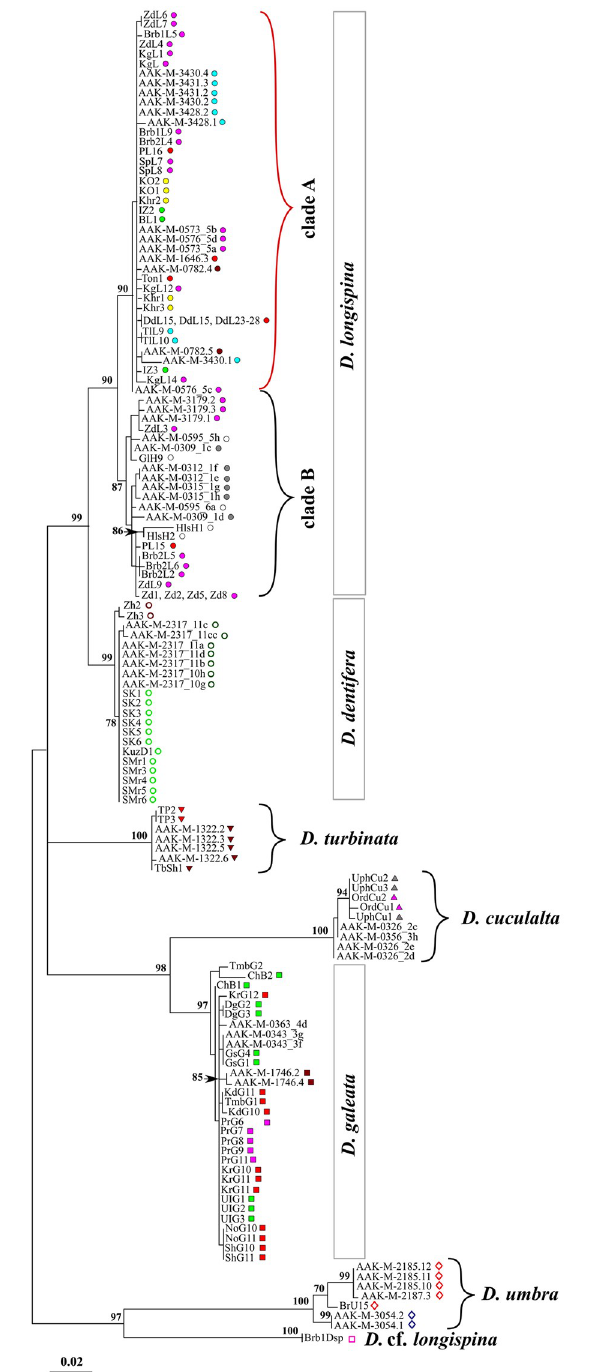
Fig 2. Maximum likelihood phylogenetic tree for species of the D . longispina complex based on the original 12S dataset. ML bootstrap values above 70% are indicated for each significant node. Scale is given in expected substitutions per site. Colored geometric symbols are the same as in Fig 1 and S1